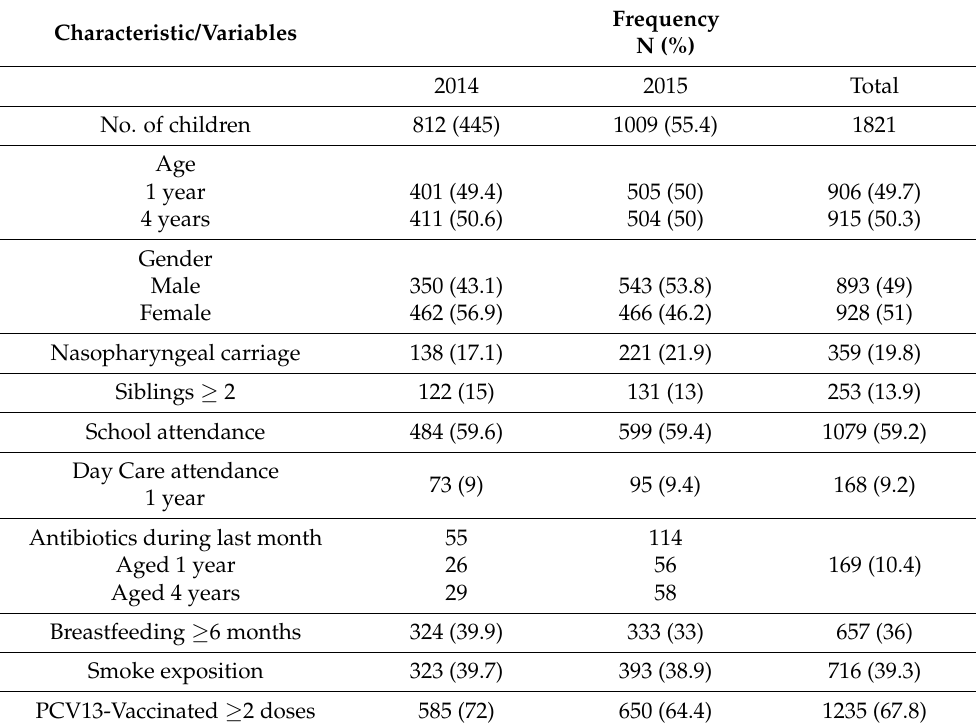
Table 1. Social and demographic characteristics of